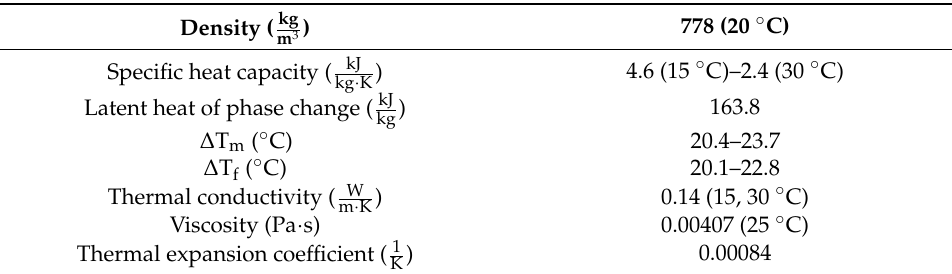
Figure 3. Temperature-dependent thermo-physical properties of RT22: ( a ) liquid density, ( b ) heat flows upon melting/solidification, ( c ) thermal conductivity and ( d ) dynamic viscosity. Table 3. Measured thermo-physical properties of RT22.